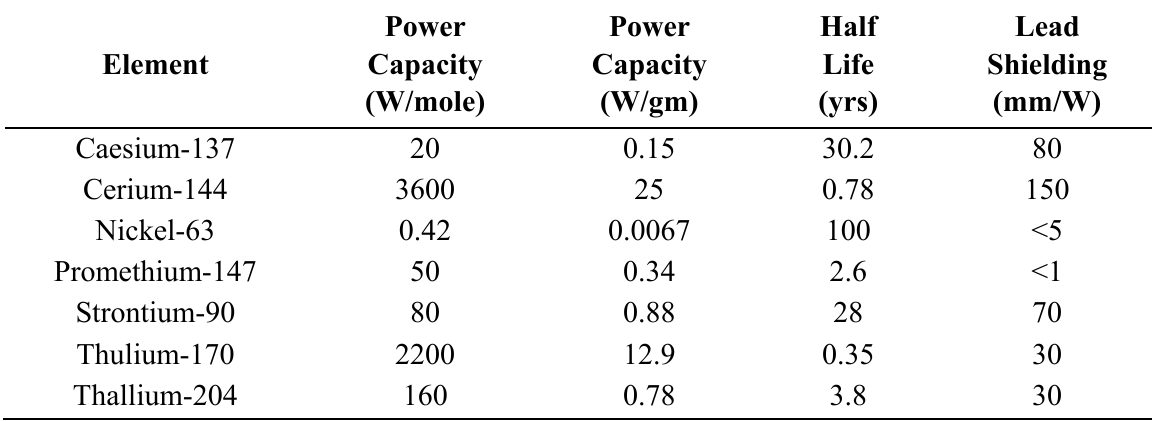
Table 2 . Decay sources (information based on [12] and